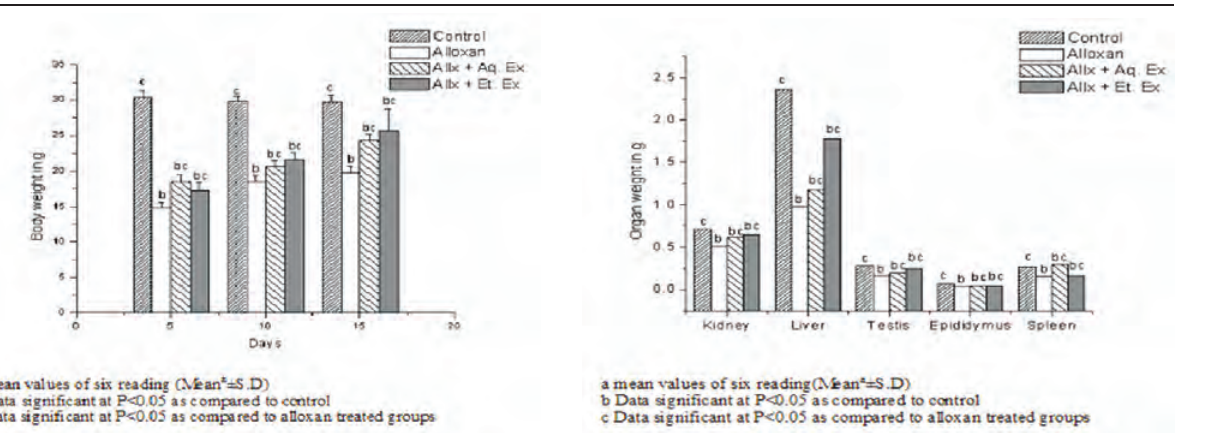
Figure-1. Effect of Aq.Ex and Et.Ex of A graveolens L. on body weight expressed as mean ±SD.